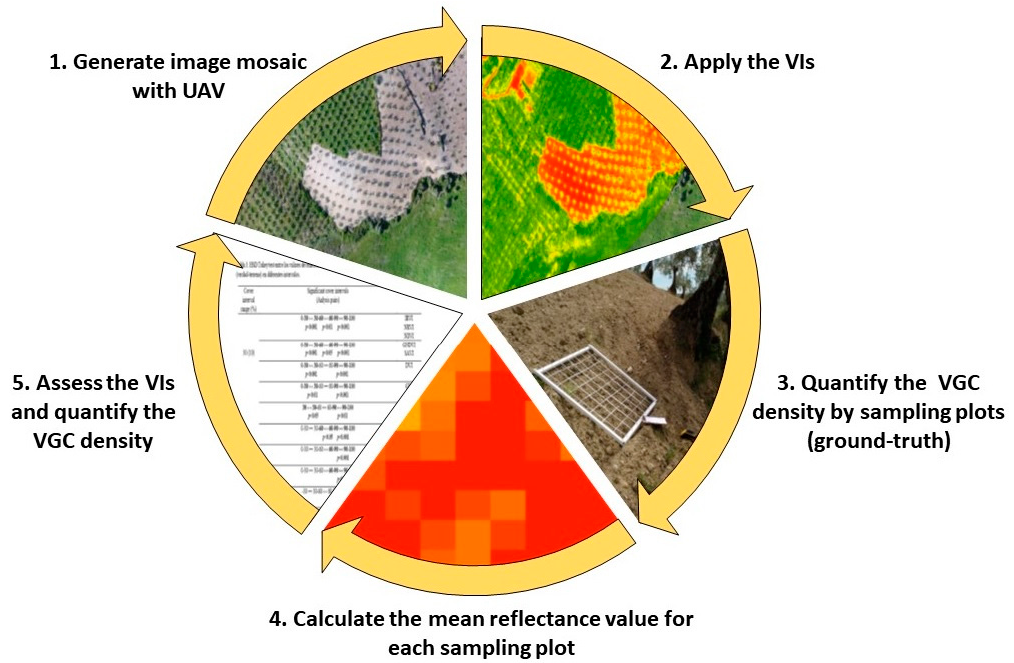
Figure 2. Stages of the method used to quantify the density of vegetation ground cover (VGC).